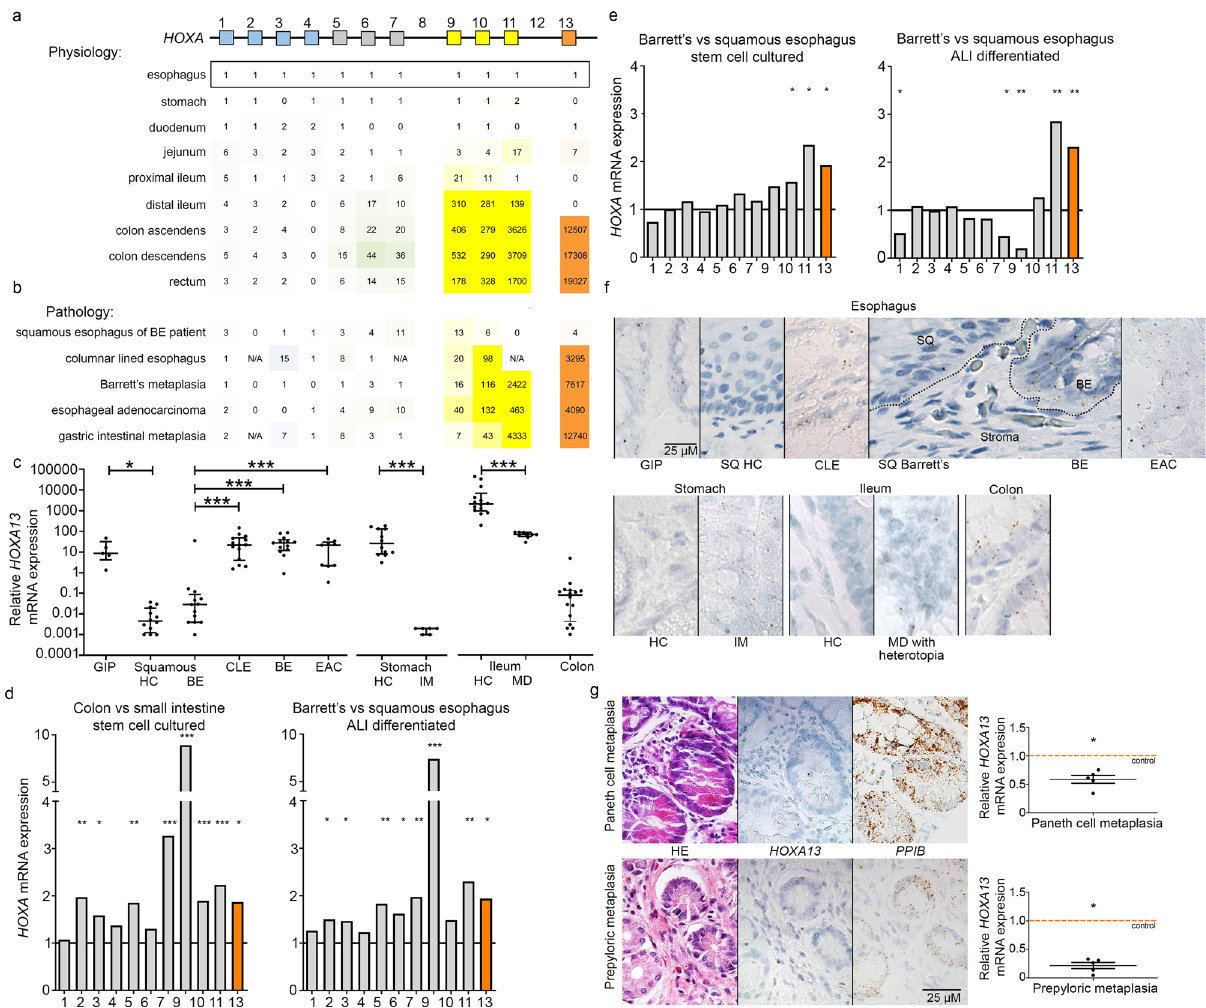
Fig. 1 HOXA cluster gene expression shows collinearity along the adult gastrointestinal tract but is deregulated in Barrett ’ s esophagus (BE), various metaplasias and esophageal adenocarcinoma (EAC). a HOXA cluster genes are collinearly expressed along the gastro-intestinal (GI)-tract of adult humans ( n = 3). Numbers represent mRNA fold changes relative to the esophagus and thus can be compared within each HOXA paralogue member but not between them. b HOXA cluster gene expression in the squamous esophagus of BE patients ( n = 13), columnar lined esophagus (CLE) ( n = 14), BE ( n = 13), EAC ( n = 12), and gastric intestinal metaplasia (IM) ( n = 12) is characterized by an upregulation of 5 ’ HOXA genes. Numbers represent mRNA fold changes relative to the esophagus of healthy individuals. c HOXA13 expression quanti fi ed by qPCR in BE, CLE, IM of the stomach, and heterotopias along the GI tract with their corresponding physiological epithelia. Squamous epithelium (SQ) Barrett ’ s and BE are derived from the same person ( n = 13). Gastric inlet patch (GIP; n = 5); healthy control (HC) squamous esophagus ( n = 12); CLE ( n = 14); BE ( n = 13); EAC ( n = 12); stomach ( n = 14); gastric IM ( n = 12); ileum ( n = 6); Meckel ’ s diverticulum (MD) with gastric heterotopia ( n = 14), and colon ( n = 9). Median ± IQR, * p < 0.05; ** p < 0.01; *** p < 0.001. For esophagus, Kruskal – Wallis test with Dunn ’ s multiple comparisons test (SQ healthy vs. GIP, p = 0.015; SQ healthy vs. CLE , p < 0.0001; SQ healthy vs. BE, p < 0.0001; SQ healthy vs. EAC, p = 0.0009). For stomach and ileum, Mann – Whitney test (two-tailed), p < 0.0001. d HOXA cluster genes, in particular 5 ′ HOXA genes including HOXA13 , have a higher expression in the large intestine ( n = 3 in technical duplicate) compared to the small intestine ( n = 3 in technical duplicate), in both stem cells (left panel) and differentiated cells (right panel). Normalization was performed by setting mRNA expression to 1 for the small intestine. * p < 0.05; ** p < 0.01; *** p < 0.001. This fi gure includes no estimate of variance as the empirical Bayes-moderated two-sided t-statistic was used which does not generate a standard error. e 5 ′ HOXA cluster gene expression in BE is higher compared to the squamous esophagus in stem cell and air-liquid interface (ALI) differentiated cultures. n = 12 (BE) versus n = 2 (squamous esophagus) in technical duplicates are depicted for stem cell cultures and n = 1 each for ALI differentiated samples in technical duplicates. Normalization was performed by setting mRNA expression to squamous esophagus. * p < 0.05; ** p < 0.01; *** p < 0.001. This fi gure includes no estimate of variance as the empirical Bayes-moderated two-sided t-statistic was used which does not generate a standard error. f Deregulation of HOXA13 expression in gastrointestinal tract pathology as evaluated with RNA in situ hybridization in clinical samples. HOXA13 is upregulated in IM and heterotopia and downregulated in pyloric and Paneth cell metaplasia in the colon. One sample of each tissue type was analyzed. g Downregulation of HOXA13 expression (corrected for peptidylprolyl isomerase B - PPIB expression) relative to adjacent non-metaplastic tissue, was observed for Paneth cell metaplasia ( n = 5; FC 0.59; p = 0.0003) and pyloric metaplasia ( n = 5; FC 0.22; p = 0.0001) (lower panels). Unpaired t-test (two-tailed). Representative images of hematoxylin and eosin (HE) staining, HOXA13 RNA-scope, and PPIB reference gene RNA-scope of Paneth cell metaplasia (from the colon) present in two glands to the bottom right (upper panels) and pyloric metaplasia (from the colon) in the top left two glands (middle panels) are shown.